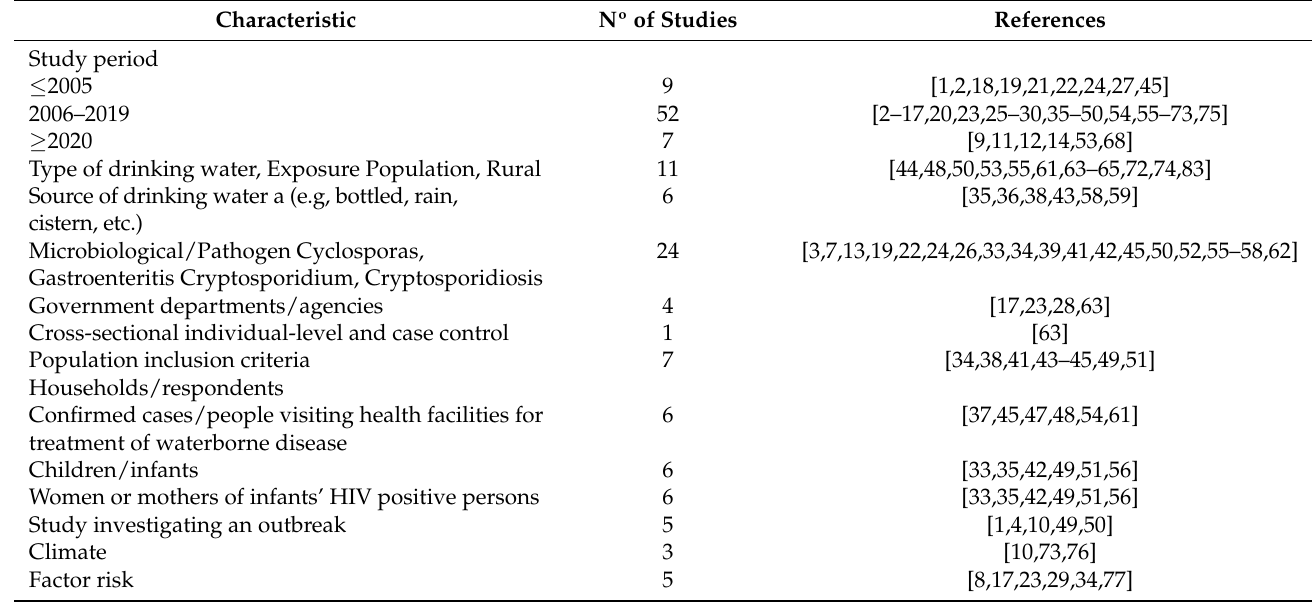
Table 2. Results of the studies included in the scope